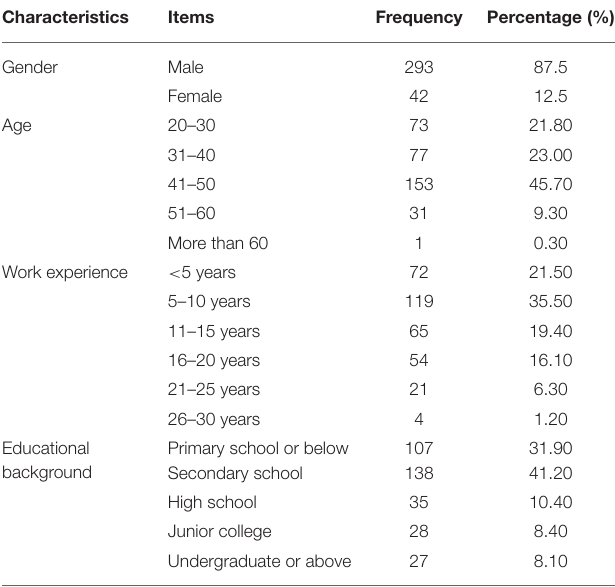
TABLE 1 | Demographic characteristics of the respondents ( N =